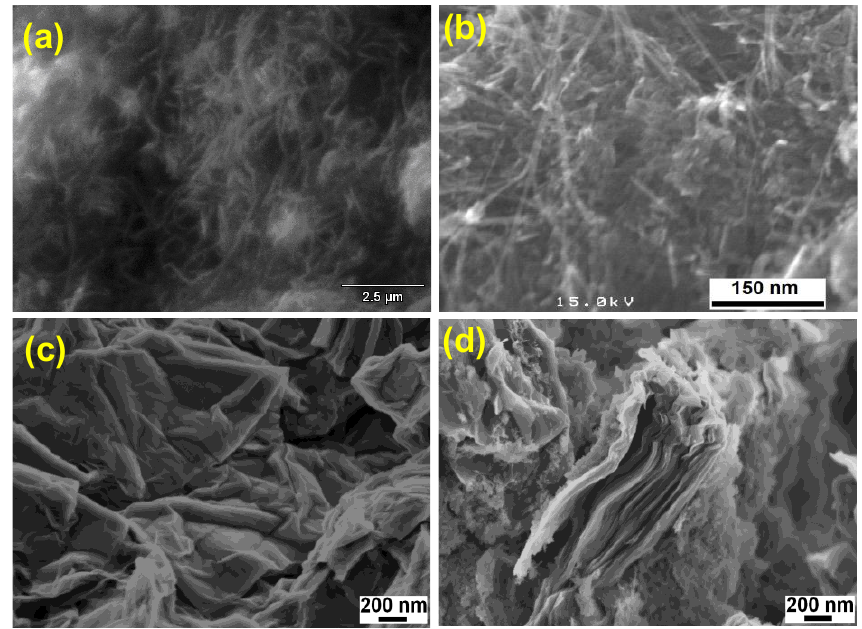
Figure 2. SEM images of ( a ) CNTs-COOH, ( b ) CNTs-HAP, ( c ) graphene oxide, and ( d ) GR-HAP.